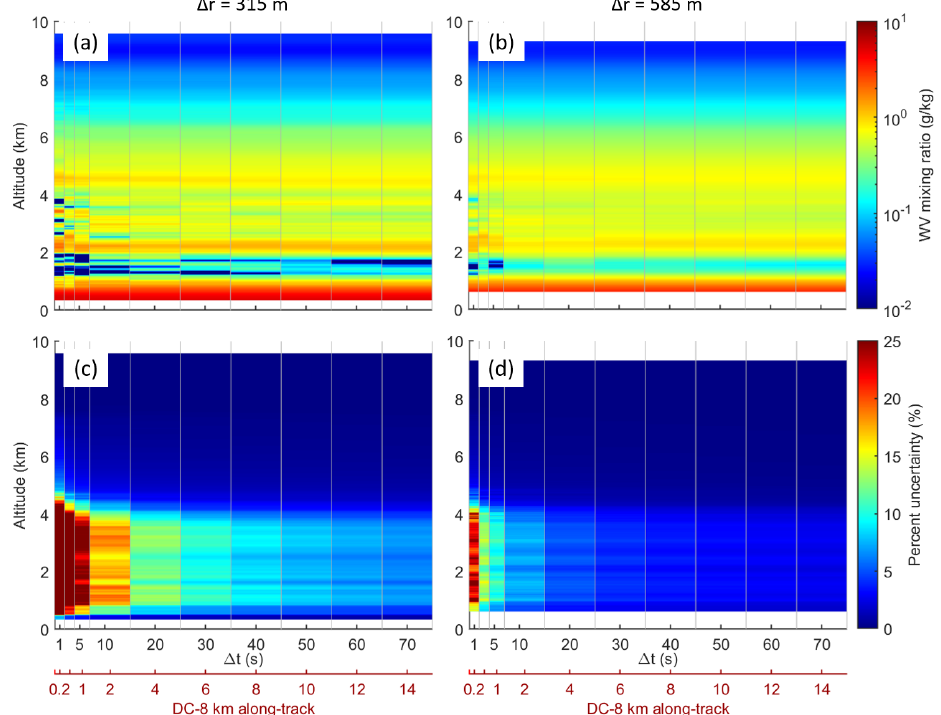
Figure 3. Plots showing (a, b) WV mixing ratio and (c, d) the associated statistical uncertainty for different temporal and range resolutions for a single profile centered at 01:02UTC from the 29 April 2019 flight (this profile is also shown in Fig. 4). Panels (a) and (c) have (cid:49)r = 315m throughout the profile, while panels (b) and (d) have (cid:49)r = 585m. The x axis indicates different temporal resolutions ( (cid:49)t ), which translate to along-track horizontal resolution calculated for the typical DC-8 flight